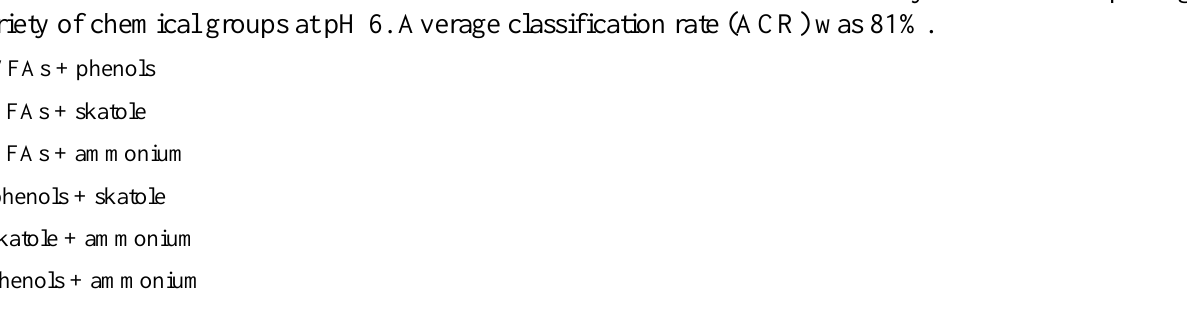
Figure 2. Classification rates for validation sets of different test mixtures of key odorants f comprising a variety of chemical groups at pH 6. Average classification rate (ACR) was